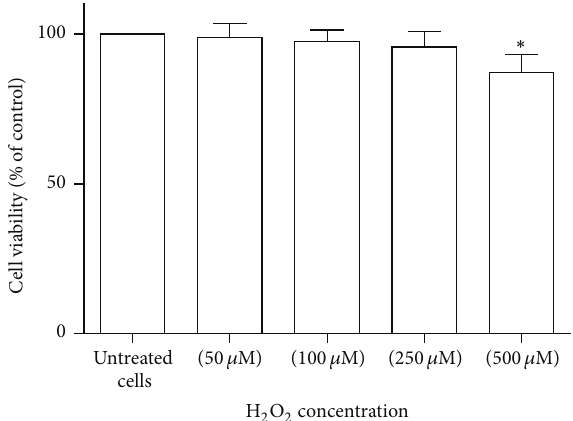
Figure 1: Assessment of PBMCs viability in response to melatonin treatment. Cells were incubated with increasing concentrations of melatonin (1nM, 1 𝜇 M, and 1mM) for 12h and cell viability was determined by MTT assay. The MTT assay was performed in triplicate and data are reported from the mean of triplicates. Data are expressed as means ± SEM.